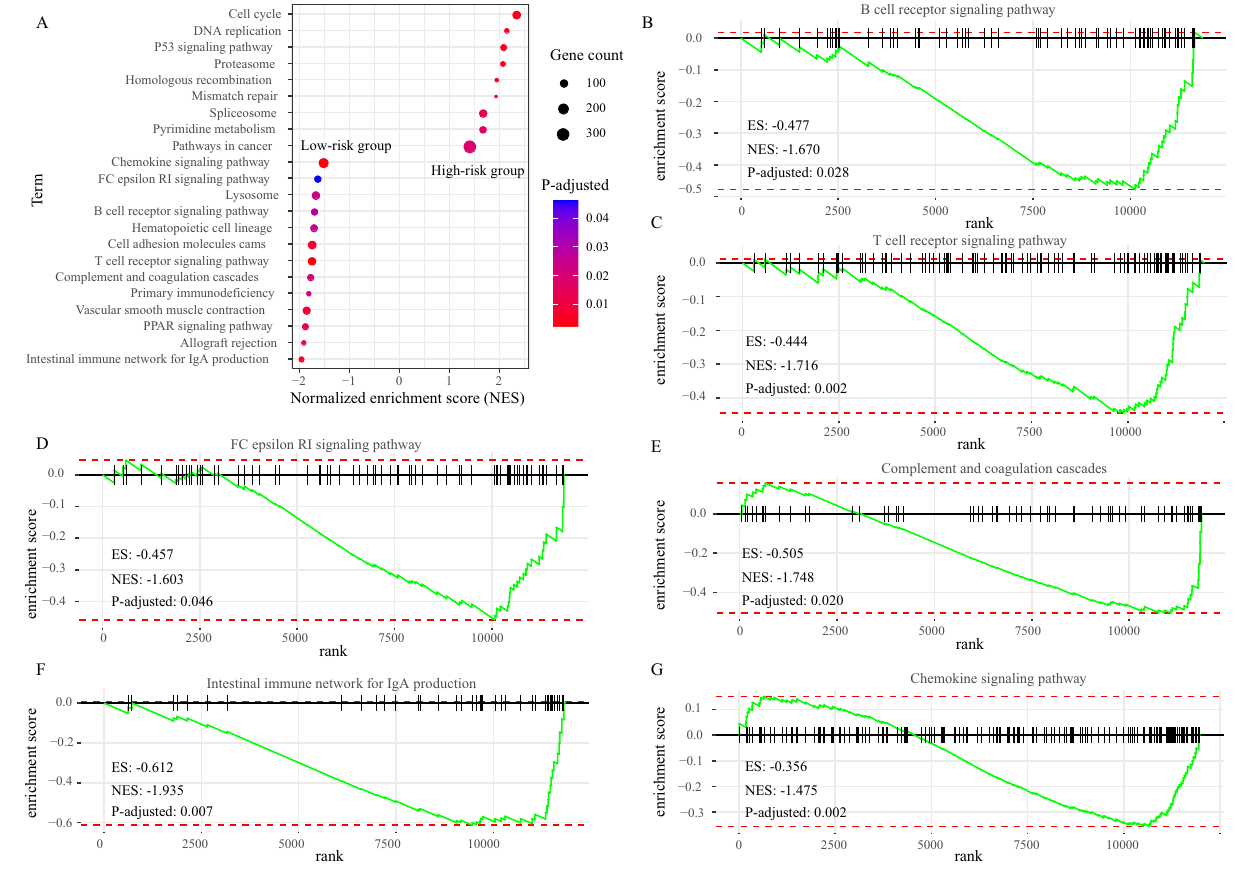
Figure 8. Gene set enrichment analysis (GSEA) between high and low immune risk groups. ( A ) 22 KEGG pathway-related gene sets, including 9 pathways in high0resk group and 13 pathways in the low-risk group. The X axis represented NES. The nodes represented pathways, the colour represented P -adjusted, the size represented gene counts. ( B–G ) 6 immune-related pathways enriched in low-risk group. NES normalized enrichment score; ES enrichment